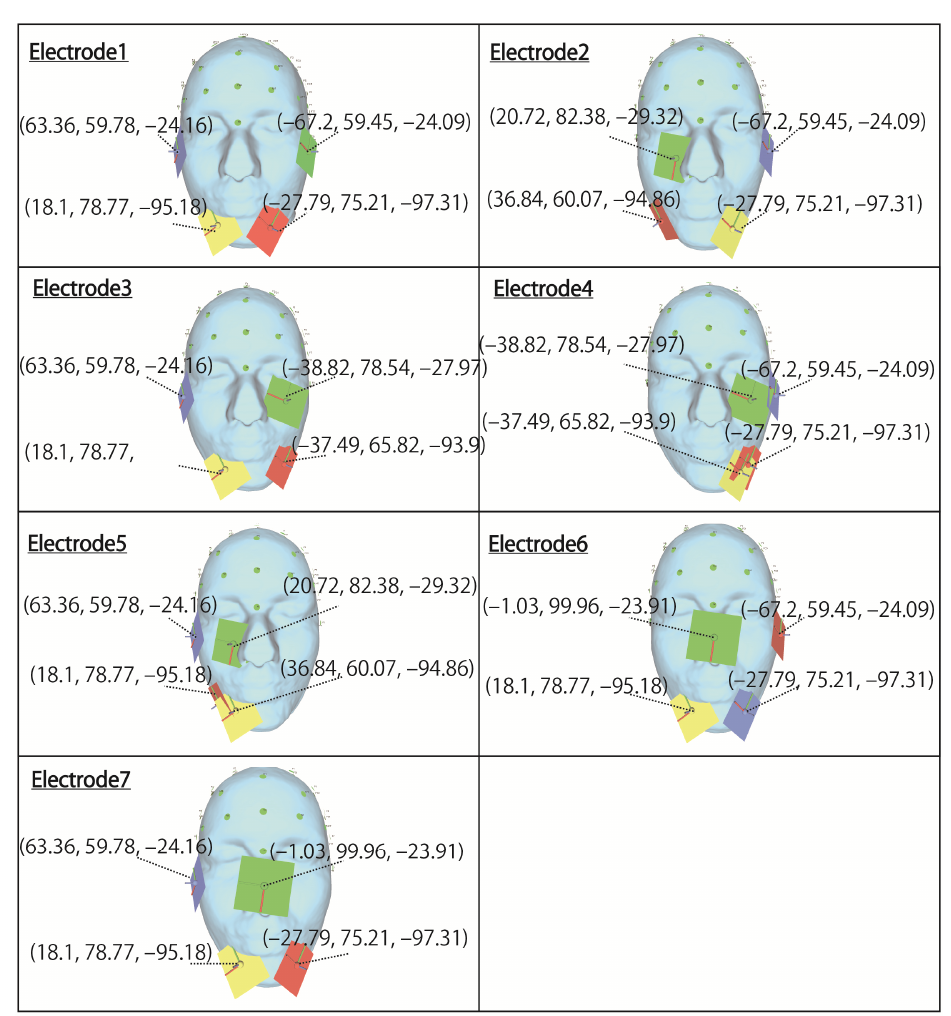
Figure 4. Electrode arrangements to stimulate the lower eyeballs with multi electrodes.